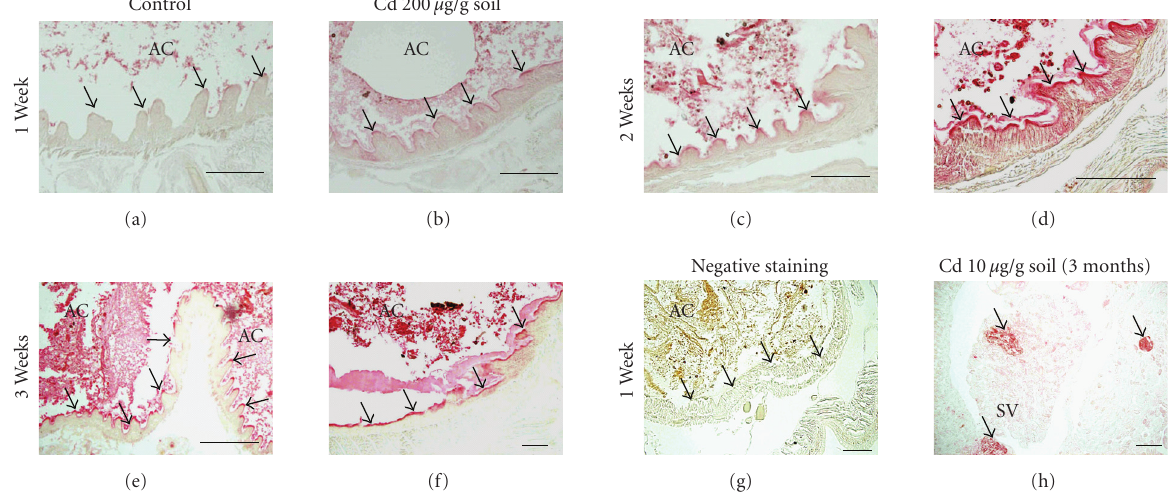
Figure 4: Immunohistochemical analyses of 8-oxo-dG accumulation in the gut epithelial layers and seminal vesicles (SV) of E. fetida (S1). Controls for the gut epithelial layer: 1 week (a), 2 weeks (c), 3 weeks (e). The gut epithelial layer of the Cd (200 μ g/g soil) treatment group: 1 week (b), 2 weeks (d), 3 weeks (f). (g) Negative staining of Cd (200 μ g/g soil, 1 week) with a 2% bovine serum albumin solution. Arrowheads show the gut epithelial layer. AC: alimentary canal. (h) The SV. Arrowheads show positive signals in SV. All scale bars are 100 μ m. (Data of (h) are modified by Nakashima et al.